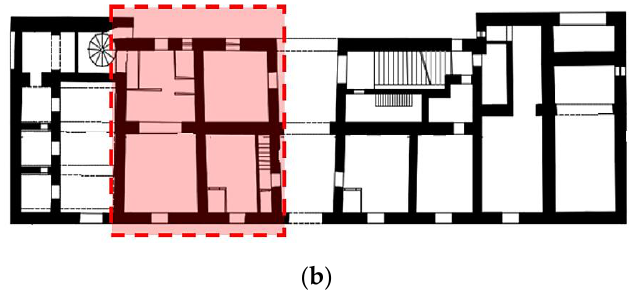
Figure 8. Numerical model of the case study buildings: ( a , b ) whole aggregate; ( c , d ) intermediate S.U.; ( e , f ) head S.U. Simultaneously, the previously mentioned structural units were also analysed in iso- lated conditions to estimate their global seismic response compared to that of SUs placed in clustered conditions. These structural models are presented in Figure 9.